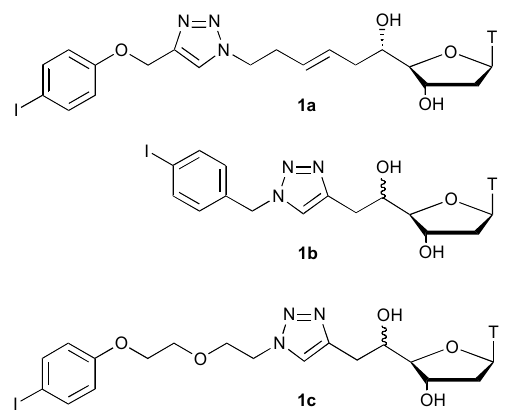
Figure 1. Substrates for the methyl transfer